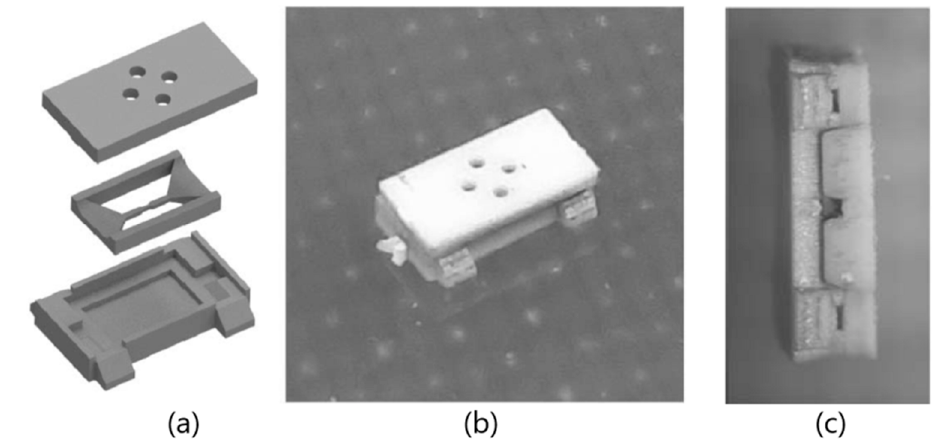
Figure 3. ( a ) 3D model assembling of SOT-23 package; ( b ) The top view of SOT-23 assembled package; ( c ) The side view SOT-23 assembled